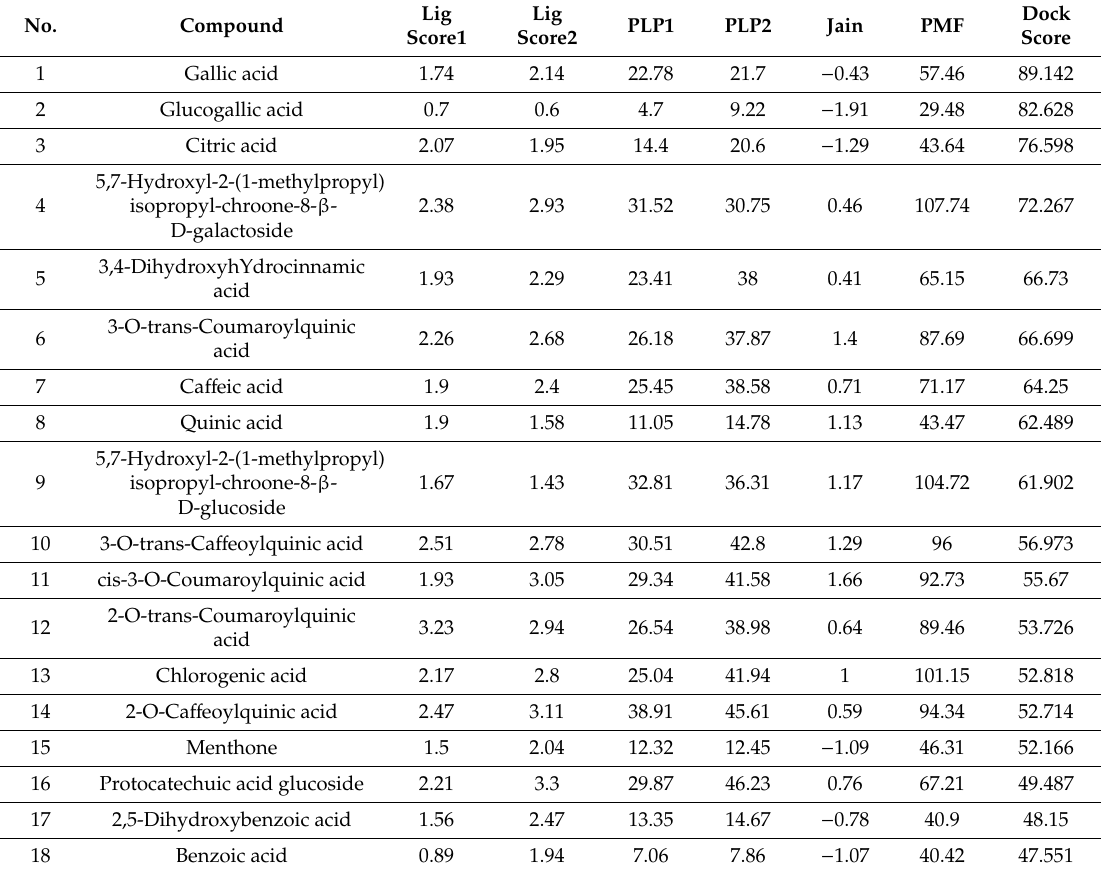
Table 3. Docking results of E. globulus leaves and